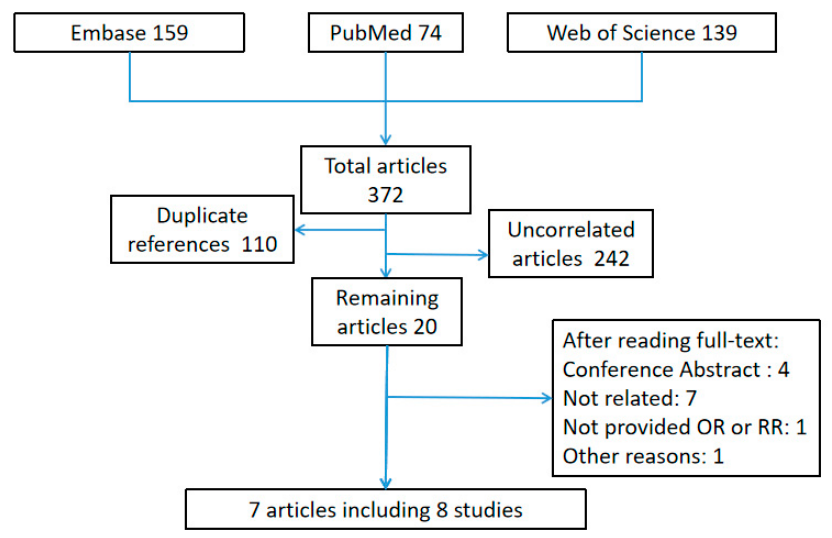
Figure 1. Literature search result (OR, odds ratio; RR, relative